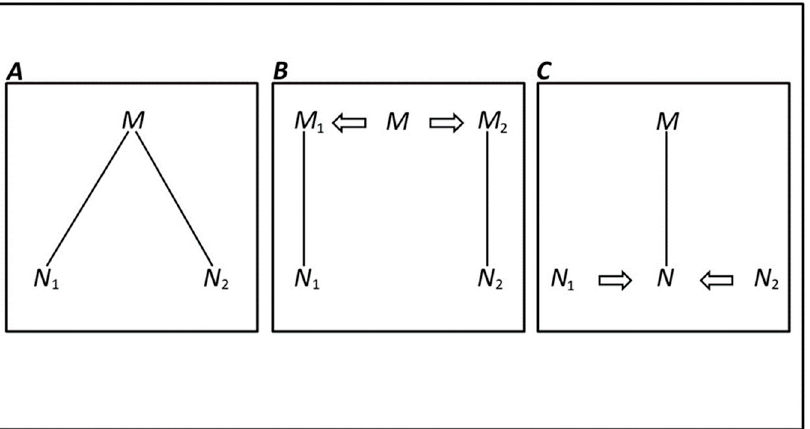
Figure 3. ( A ) displays working memory (M) being realised by two separate physical properties (N1 and N2, respectively). ( B ) shows working memory (M) being split into working memory updating (M1) and working memory capacity (M2), M1 and M2 being realised by two separate physical properties (N1 and N2, respectively). ( C ) shows the intention to grasp an object (M) being realised by the mean neural activity of some specific neuronal structures (N1 and N2), resulting in a singular unified realiser (N).